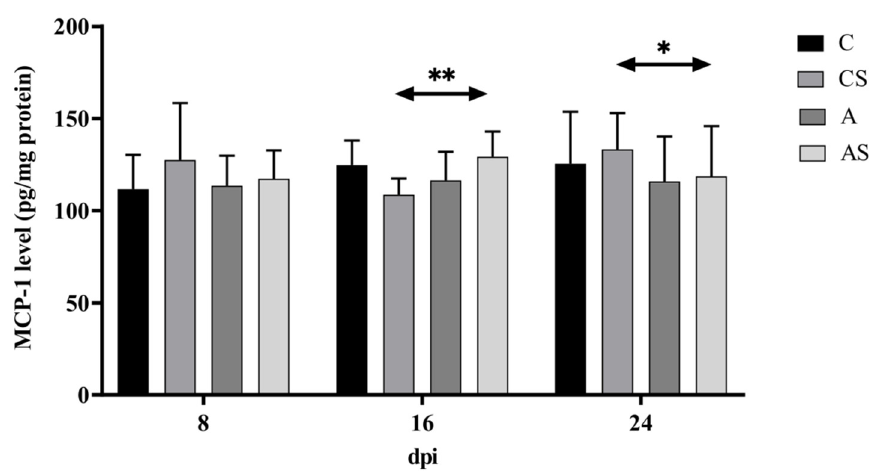
Figure 3. The level of monocyte chemotactic protein 1 (MCP-1) in the kidneys of mice infected with Acanthamoeba spp. MCP-1 was determined using ELISA and it is expressed in pg/mg protein. Data represent the means ± standard deviation for six independent experiments. (A: Immunocompetent mice infected with Acanthamoeba spp.; AS: Immunosuppressed mice infected with Acanthamoeba spp.; dpi: Days post Acanthamoeba spp. infection; C: Immunocompetent mice uninfected with Acanthamoeba spp.; CS: Immunosuppressed mice uninfected with Acanthamoeba spp.; statistically significant differences * p < 0.05; ** p < 0.01).